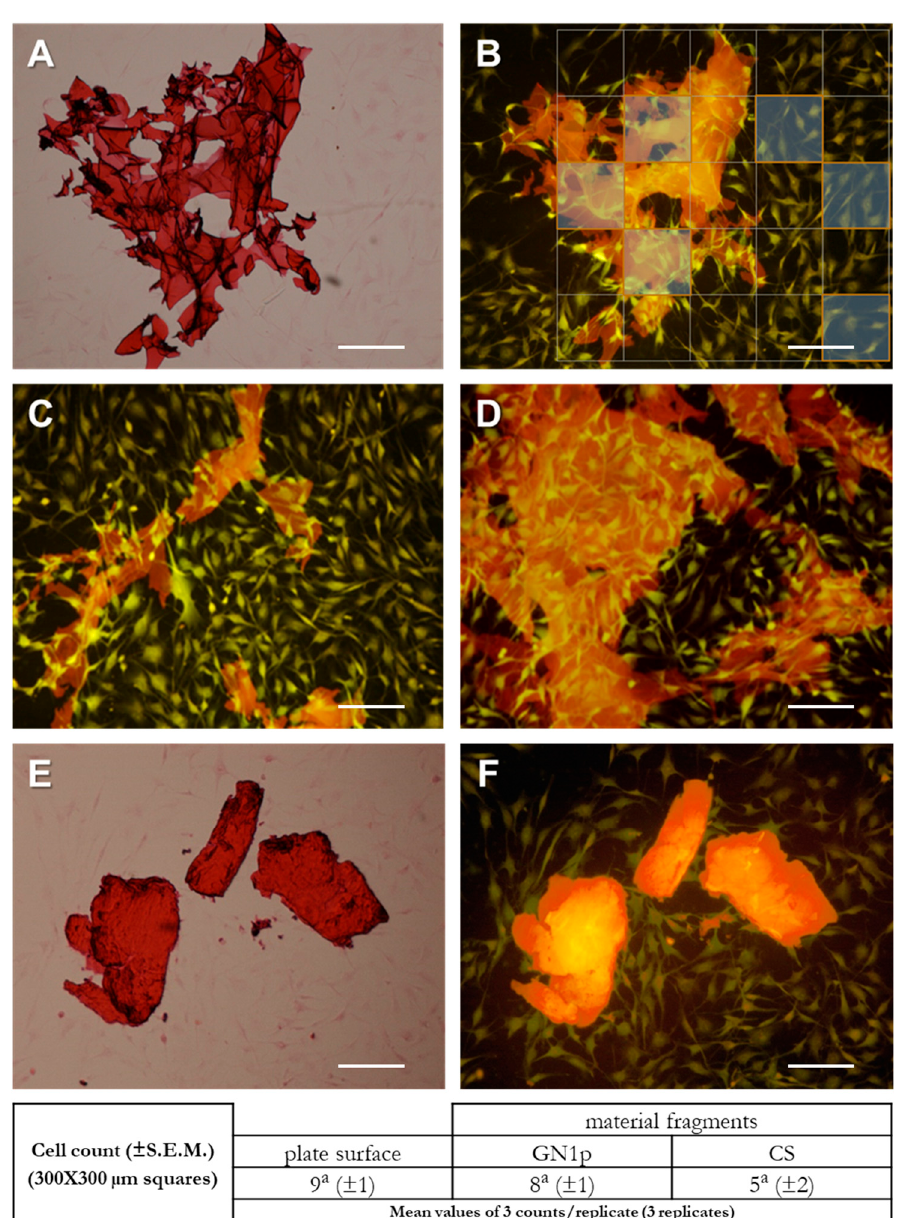
Figure 4. Evaluation of cell – material interactions by imaging of MG63 cells cultured in the presence of CS and GN1p powders. HE staining and fluorescence imaging of MG63 cells grown in the presence of GN1p ( A–D ) and CS powder ( E , F ). Representative pictures after 72 h growth in the presence of 1.5 mg/mL material powders. ( A ) Bright-field image of the cells growing on a surface area surrounding a GN1p fragment. ( B ) Fluorescence image (red fluorescence) of the same fragment. ( C , D ) Additional images showing cell adhesion on GN1p fragments with heterogeneous shapes; pictures show high efficiency of the cell spreading onto the fragments regardless size and morphology. ( E , F ) Bright-field and fluorescence images of cells in the presence of a CS powder fragment (stereoscope magnification 10×; scale bar 300 µm; Nikon red fluo filter (mcherry) ex. 562/40 em. 641/75). In B, representative 300 µm × 300 µm squares are reported to depict the selection of the areas for the cell counts. In the table below: cell numbers from three different counts per biological replicate (3 different replicates) were performed; data are reported as mean values (±S.E.M.); statistical analysis: Student’s t -test; different/equal letters indicate statistically different/equal values.